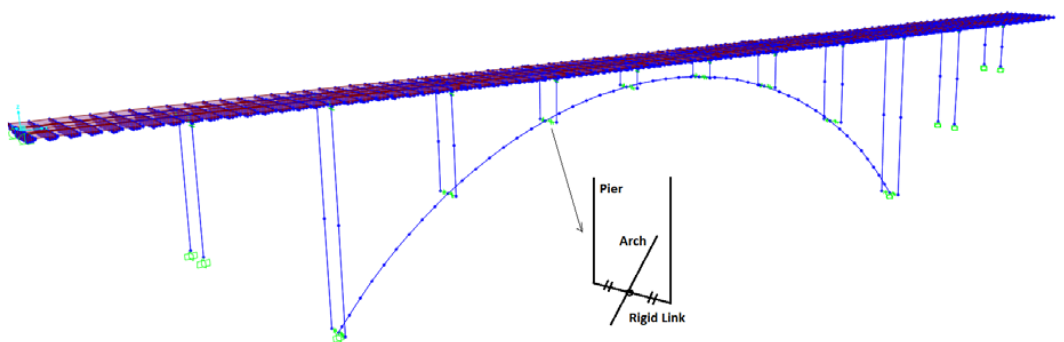
Figure 5. Three-dimensional FEA model of the bridge constructed using CsiBridge.